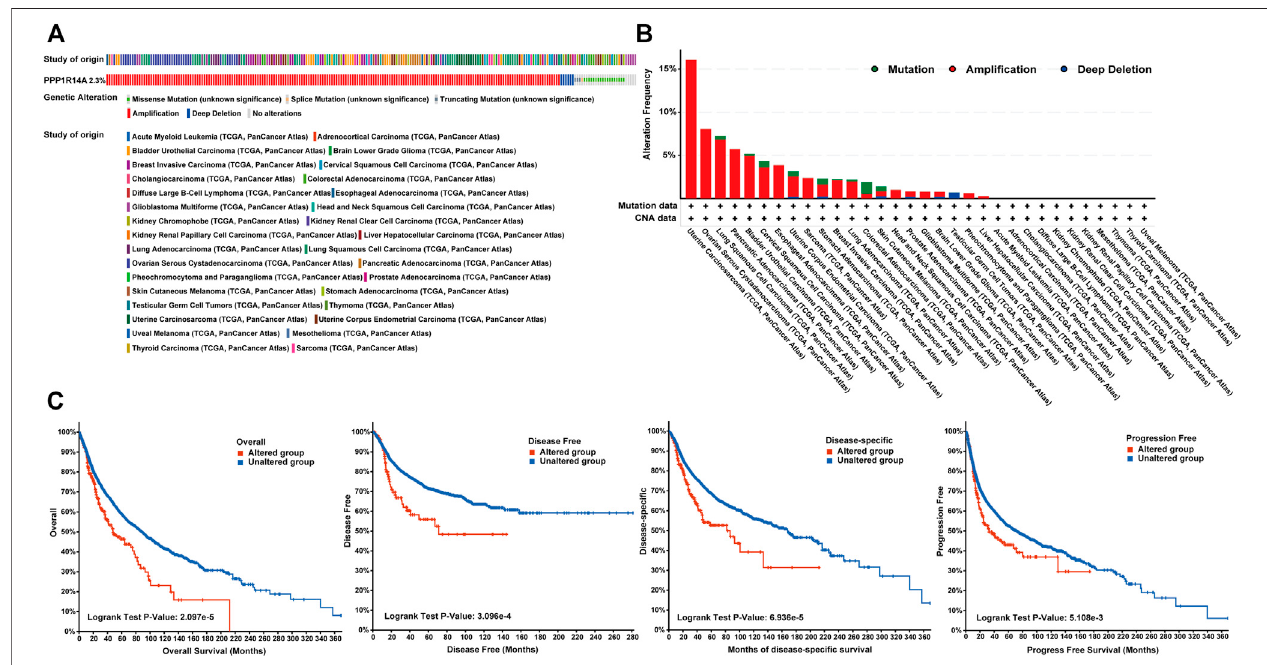
FIGURE8| SummaryofgeneticalterationsofPPP1R14Aindifferenttumors. (A) Alterationfrequencywithdifferenttypesofcopynumbervariationsandmutations examined (B) . Effect of PPP1R14A alteration status on overall, disease-free, disease-speci fi c and progression-free survival of cancer patients investigated (C)